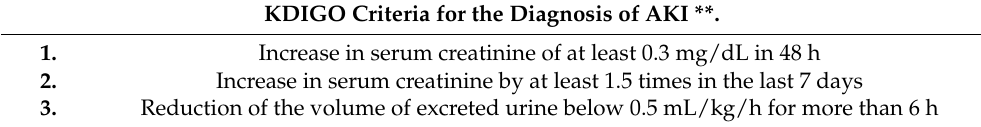
Table 1. KDIGO criteria used to diagnose AKI [24,25,30]. KDIGO Criteria for the Diagnosis of AKI